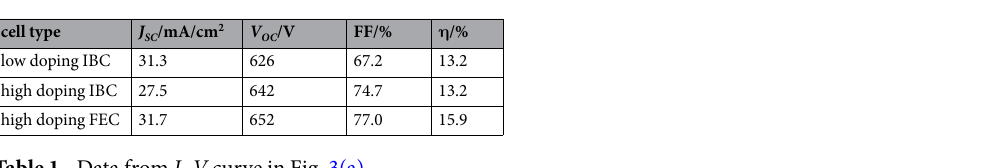
Table 1. Data from J – V curve in Fig.